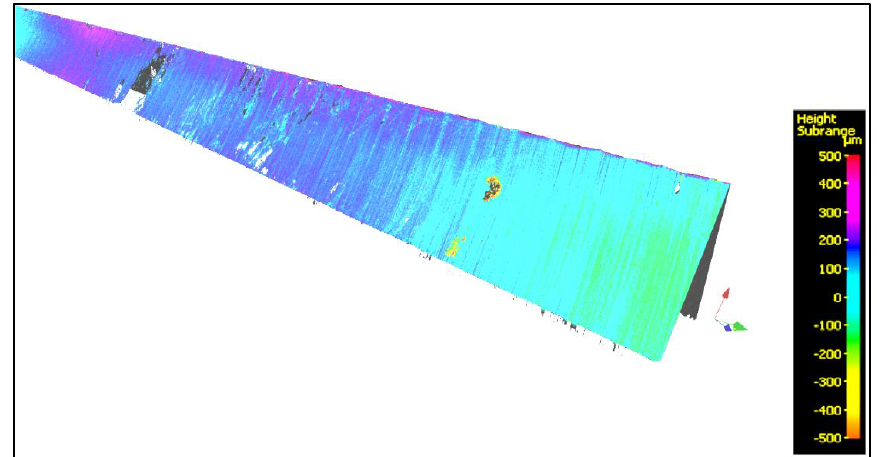
Figure 10. Cutting edge wear - knife No. 2 - Norway spruce.